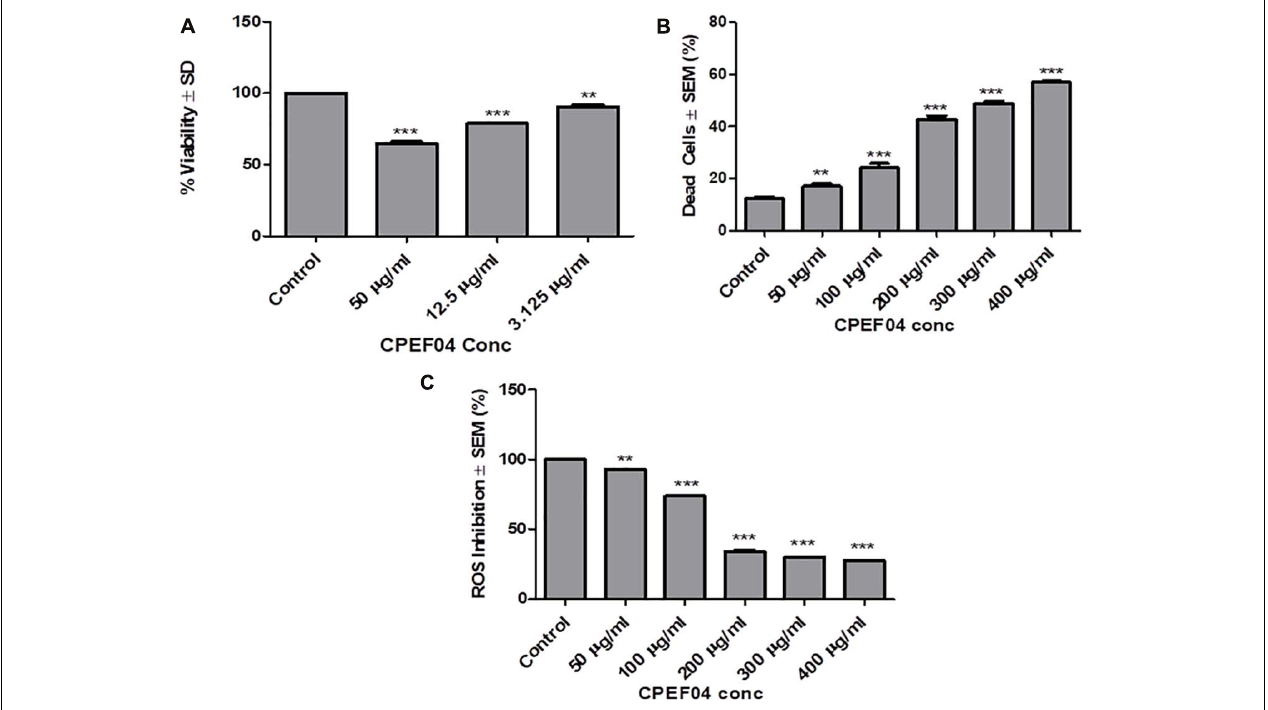
FIGURE 11 | Effect of CPEF04 culture filtrate dried powder (CFDP) on HEK 293T normal cell lines (A) , HeLa cancer line (B) , and reactive oxygen species inhibition (C) . * defines significance level in comparison to control after unpaired t test. *** p <